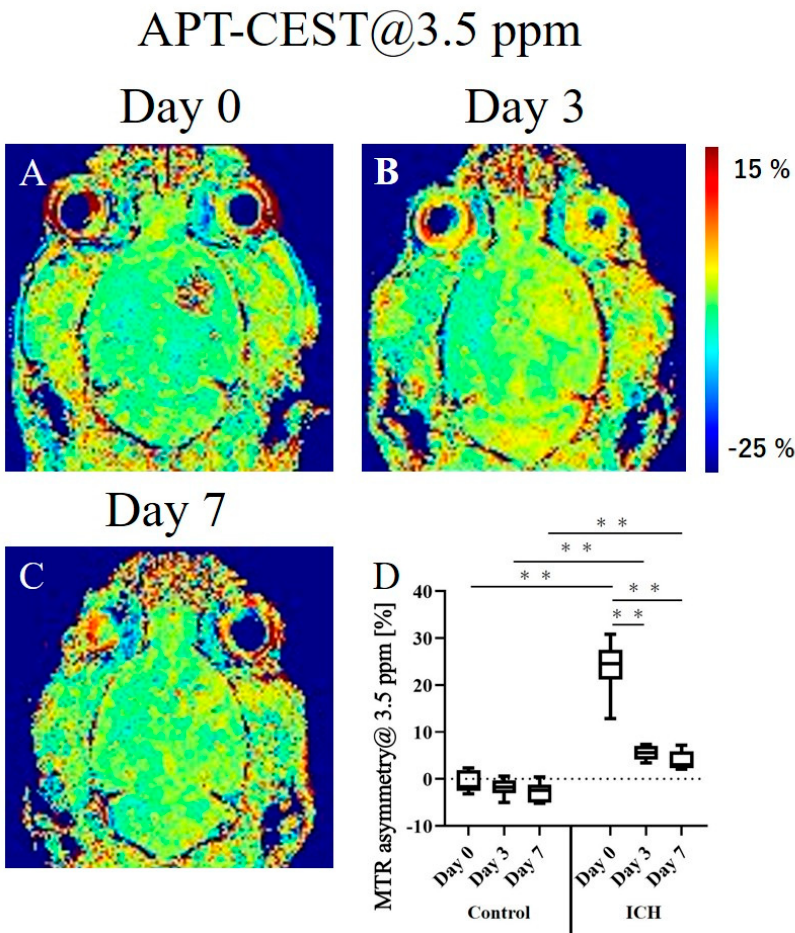
Figure 3. Representative MTR asymmetry maps of the intracranial hemorrhage (ICH) rat model obtained using APT-CEST imaging on postoperative days 0 ( A ), 3 ( B ), and 7 ( C ). ( D ) The graph depicts the longitudinal changes in MTR asymmetry value at 1.8 ppm of the hemorrhage site and the normal site. ** p < 0.01.